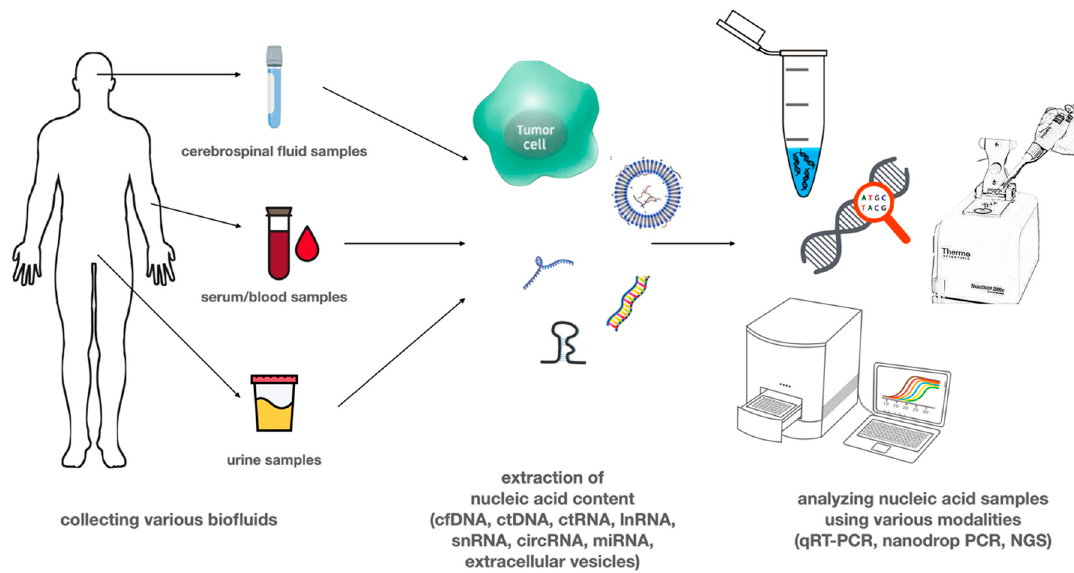
Figure 1. Liquid biopsy samples used in glioblastoma research. Liquid biopsy samples can be collected from any bodily fluid, including blood, urine, saliva, bronchial fluid, ascites, or cerebrospinal fluid (CSF). Due to disease characteristics, serum, CSF, and urine are the most commonly used in glioblastoma. Samples contain circulating tumor cells and other forms of nucleic acid, which are then used for quantitative and qualitative analysis.